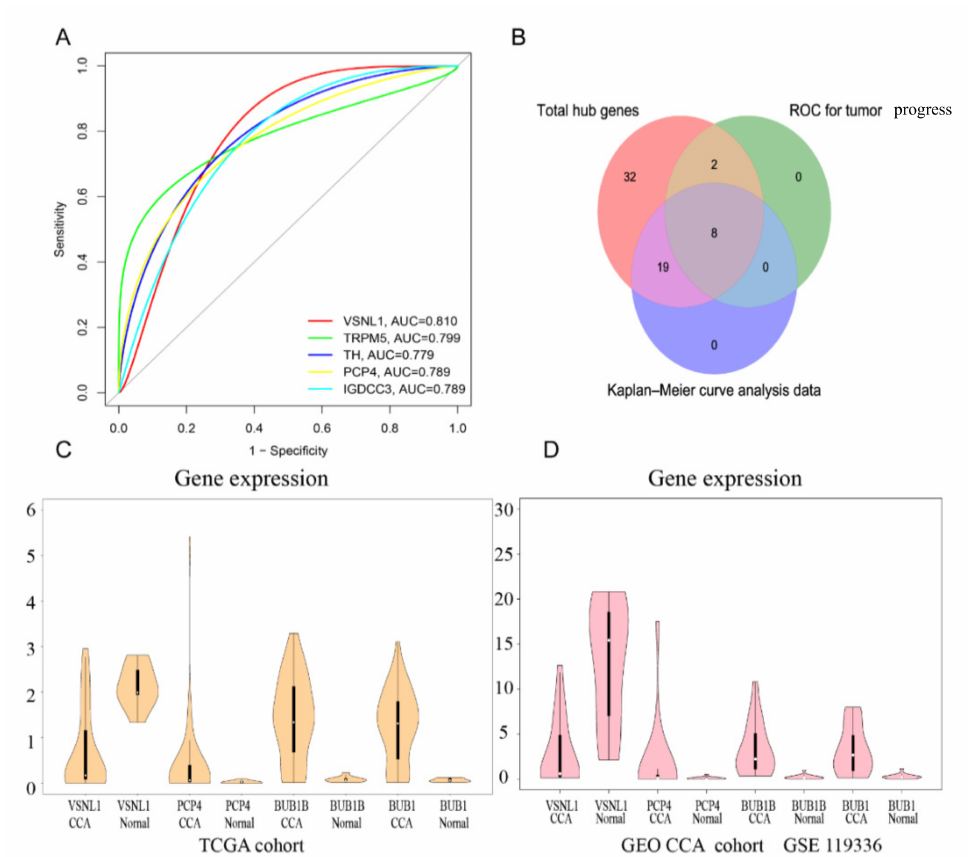
Figure 7. Analysis of hub genes. ( A ) ROC curve analysis showed that five hub genes could distinguish tumorigenic progression of CCA. ( B ) Venn plot of eight hub genes. ( C ) mRNA expression of 4 hub genes of 36 patients with CCA, compared to the 9 adjacent tissues, according to the TCGA CCA database. ( D ) mRNA expression of 4 hub genes in 15 CCA patients and 15 adjacent tissues, according to the GSE119336